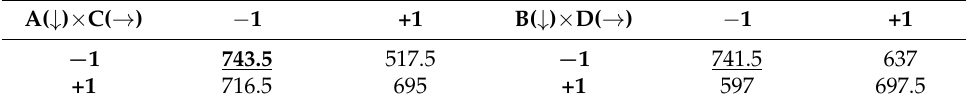
Table 6. Effect of the interactions AC and BD for hardness analysis.